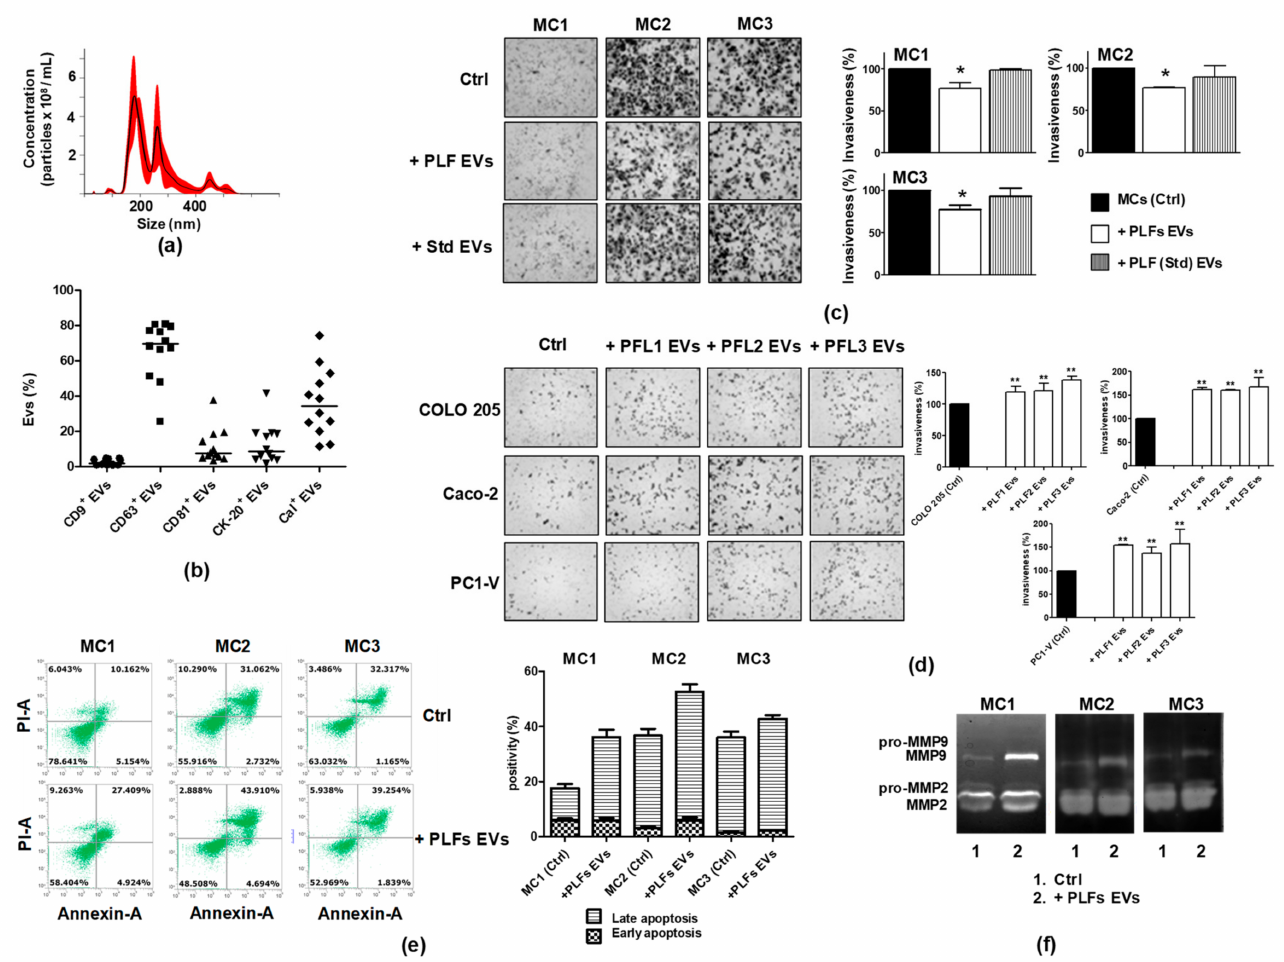
Figure 7. Biologically active EVs exist in the PLF and are engaged in establishing a pro-metastatic environment. ( a ) Representative nanoparticle tracking analyses showing the concentration and the size of EVs in the PLF. ( b ) FCM scatter plot with the median showing coexpression of CK-20 or Cal with the EV markers CD9, CD63, and CD81 in PLF EVs. ( c ) Representative images showing that a PLF EV pool isolated from a cancer patient reduces the motility of MC1, MC2, and MC3 cell lines, unlike the PLF EV pool from a non-tumor patient (Std) (magnification x100), and quantification of mesothelial cells invasion %. ( d ) Representative images showing that the PLF EV pool increases the motility of cancer cells and the quantification of tumor cells invasion %. Each value reported in the histograms ( c , d ) is the mean ± SD of three different experiments performed in triplicate (* p < 0.05 ** p < 0.01 relative to control). ( e ) FCM dot plots and quantification of AnnexinV/PI positive cells before and after applying a PLF EV pool to MC1-3, showing mainly induction of late apoptosis. ( f ) Representative gelatin zymography reveals that the addition of a PLF EV pool increases the secretion of active MMP-2/MMP-9 by MC1-3